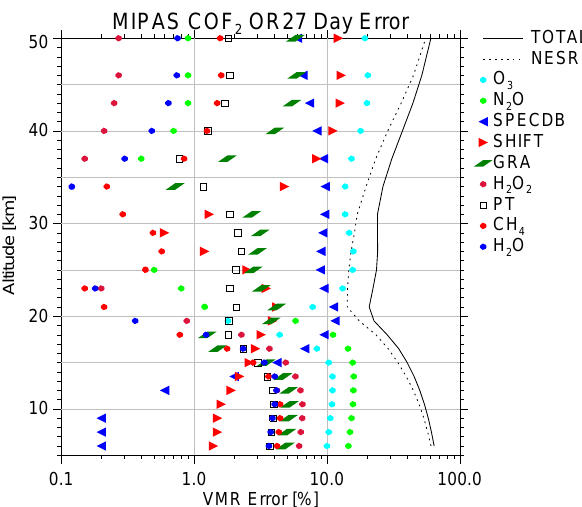
Figure 3. The single-profile total error budget for the MIPAS COF 2 retrieval (midlatitude daytime conditions). The total error is com- puted by propagating a number of independent error sources ex- pressed as spectra through the linearised form of Eq. (2), including both spectral correlations and correlations through the pressure– temperature (PT) retrieval. Note that NESR is the noise equiva- lent spectral radiance; SHIFT refers to the uncertainty in the spec- tral calibration ( ± 0.001cm − 1 ); SPECDB refers to spectroscopic database errors, which are treated simply as a single, correlated er- ror source; and GRA refers to the uncertainty due to an assumed ± 1K100km − 1 horizontal temperature gradient. More details are contained in the text. Total errors are typically 20–30% between 20 and 40km.